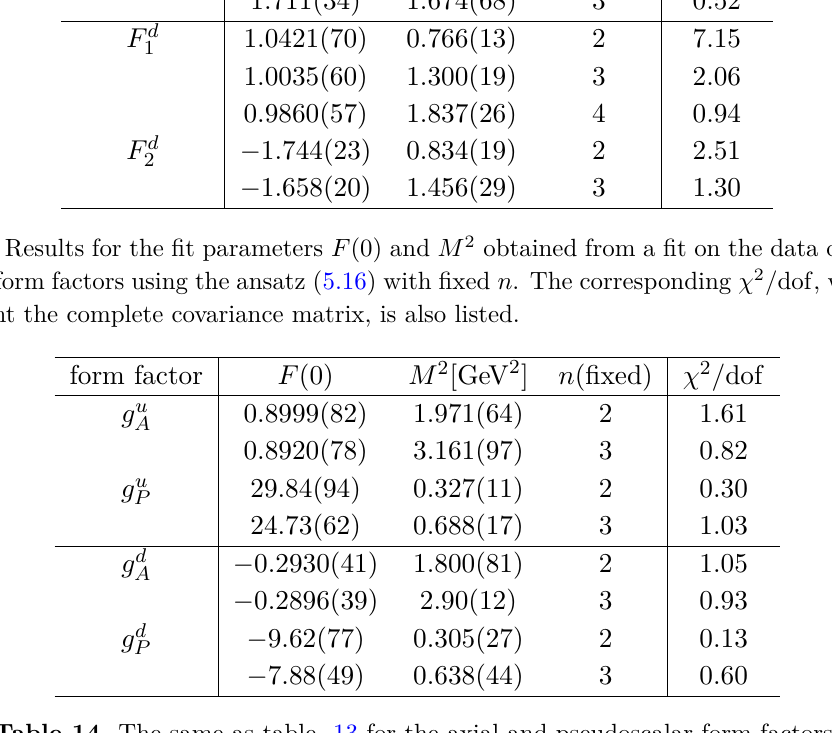
Table 14 . The same as table 13 for the axial and pseudoscalar form